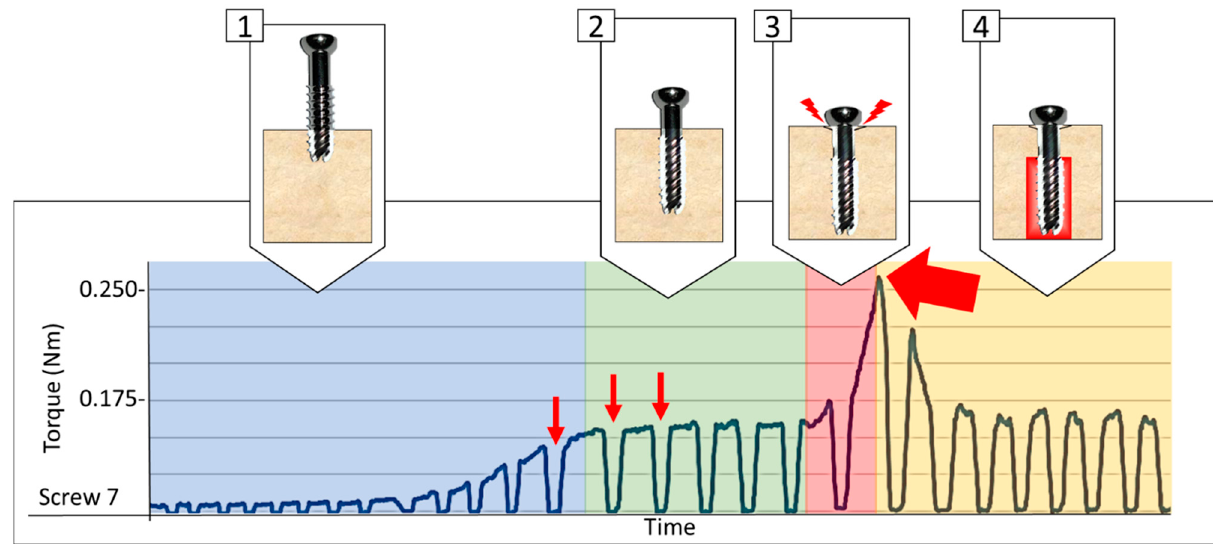
Figure 3. Example of torque [Nm] measured during instrumentation of the screws depicted in phases: (1) Insertion of the thread; (2) Screw advancement at near constant torque; (3) Compression phase: engagement of the cortex reaching maximum torque; and (4), Torque decreased to near constant value following the stripping.